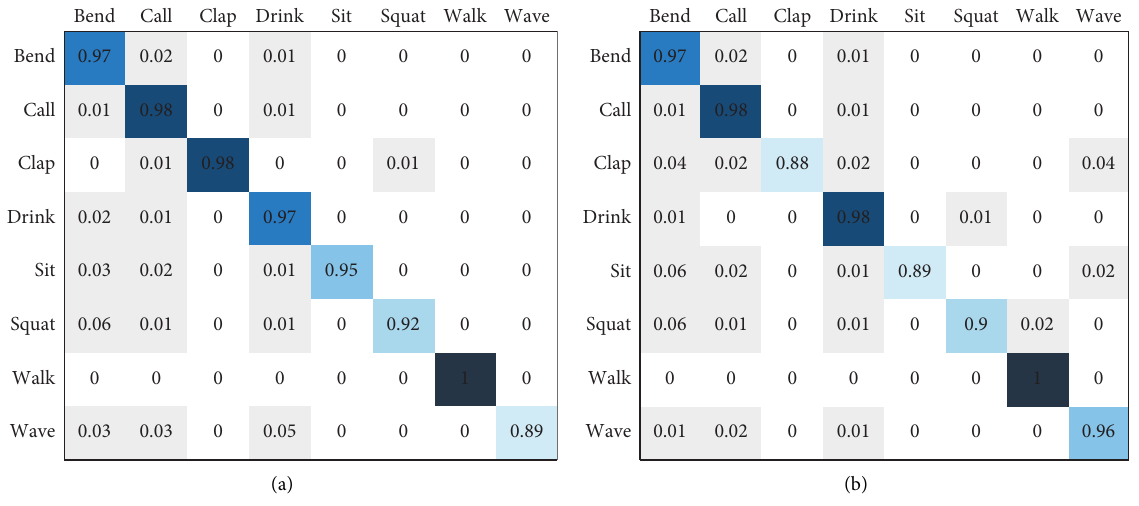
Figure 17: The confusion matrices created by (a) NISE and (b) PSE.